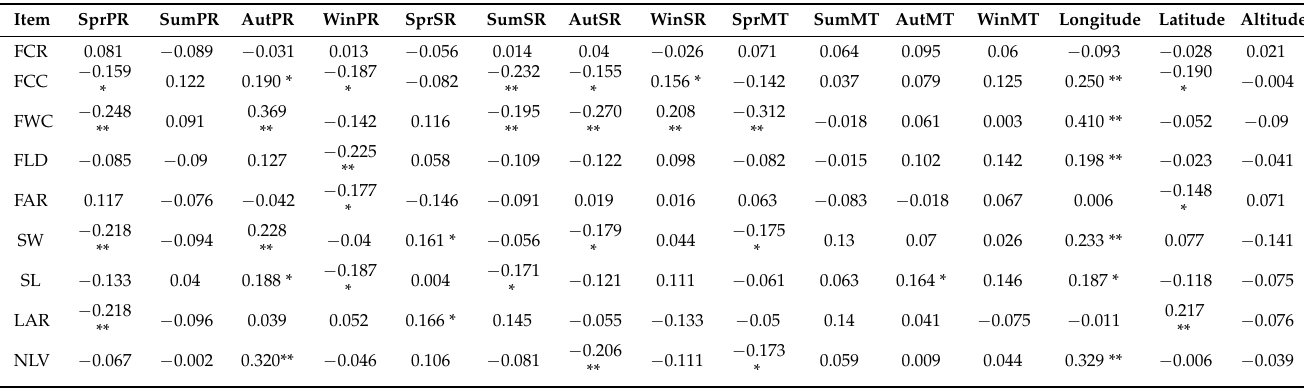
Note: Different lowercase letters for each parameter indicate significant differences among populations according to two-way analysis of variance (ANOVA) followed by Duncan multiple- range test ( α = 0.05); * represents the minimum value of morphological traits in all 179 persimmon germplasms; # represents the maximum value of morphological traits in all 179 persimmon germplasms. Table 3. Correlation analysis between the morphological traits and environmental factors for the 179 persim- mon